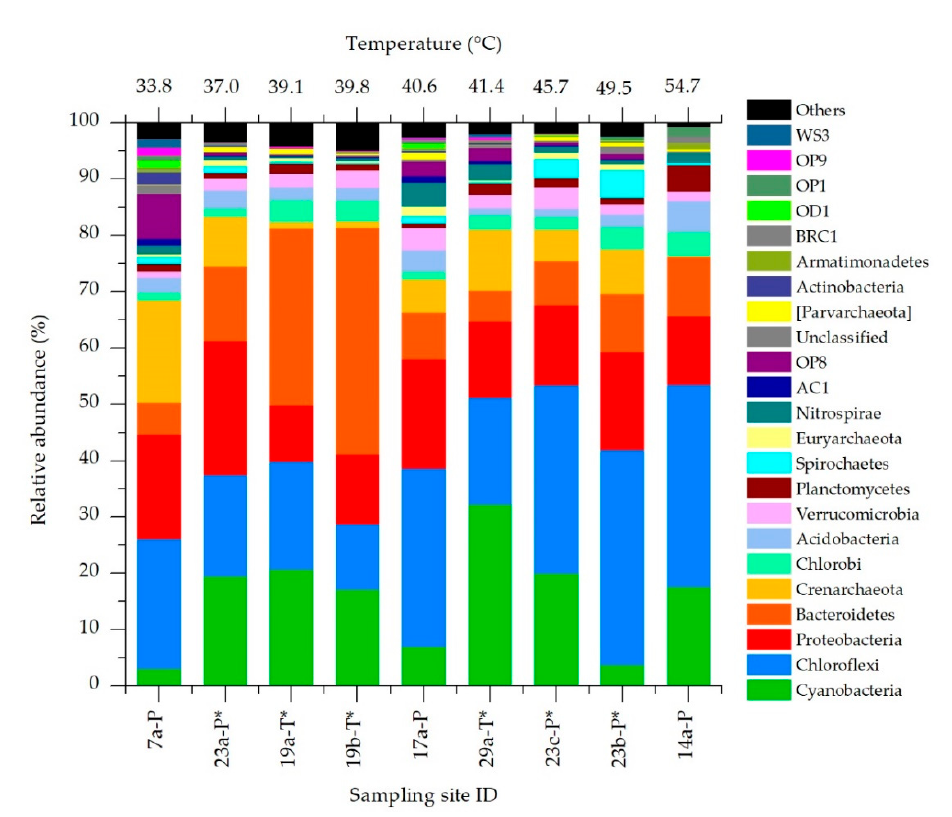
Figure 4. Relative abundance of the main phyla identified in the mature mud microbiota at different temperatures and sampling sites. Samples collected from maturation systems provided with protective roofs are indicated with *.